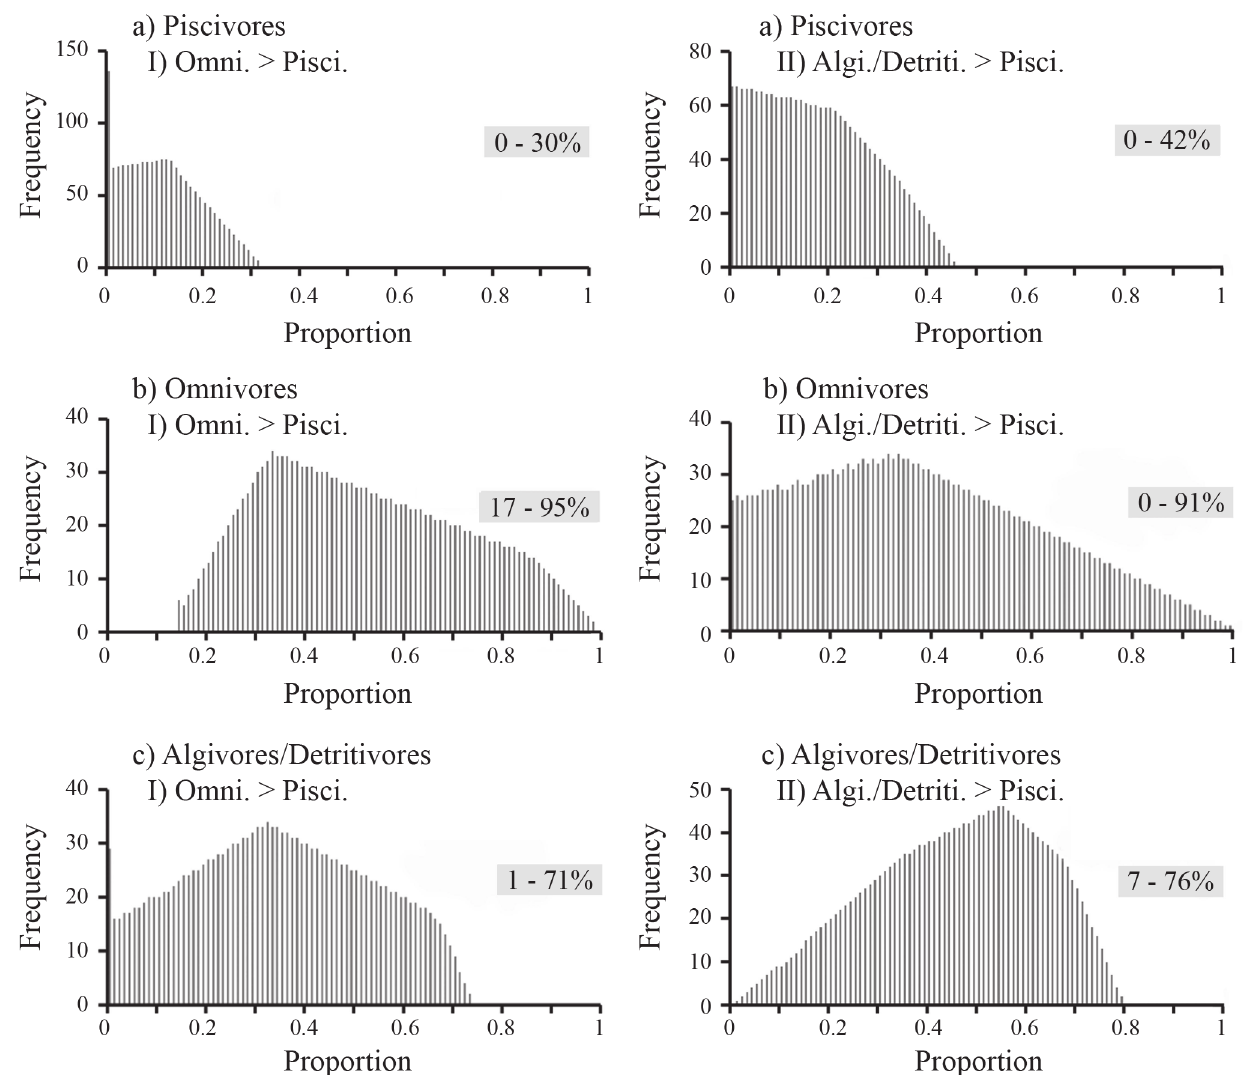
Fig. 4. Histograms of the distribution of feasible contributions of the three dietary fish groups for Arapaima : a ) piscivores, b ) omnivores, and c ) algivores/detritivores after imposing additional constraints of: I) omnivores > carnivores, and II) algivores/ detritivores > carnivores. Values in boxes are 1% percentile and 99% percentile ranges for these